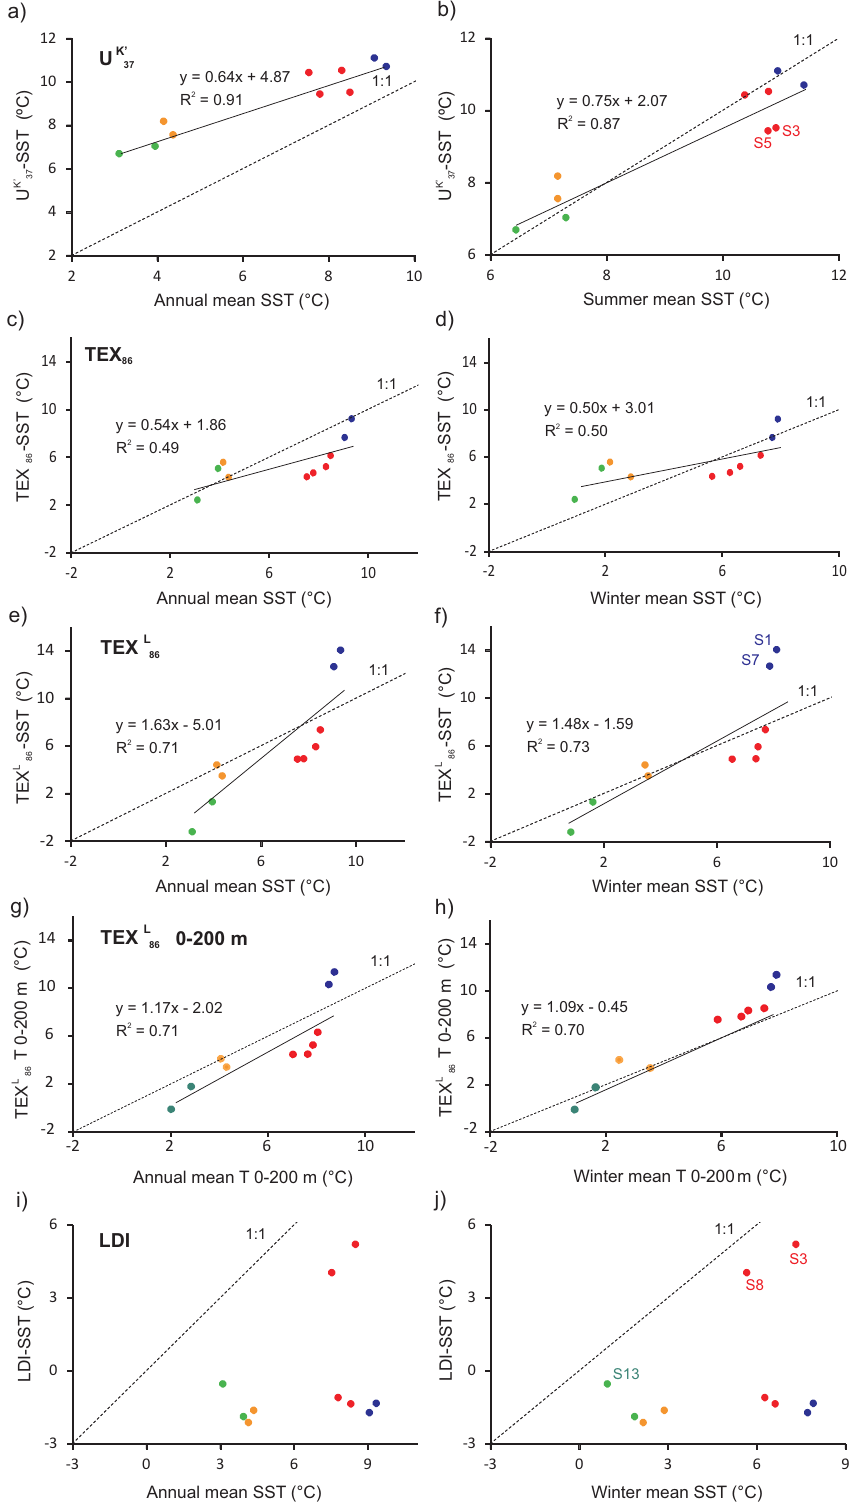
(cid:48) , TEX 86 , TEX L , TEX L 0–200m and LDI) with annual and 37 86 86